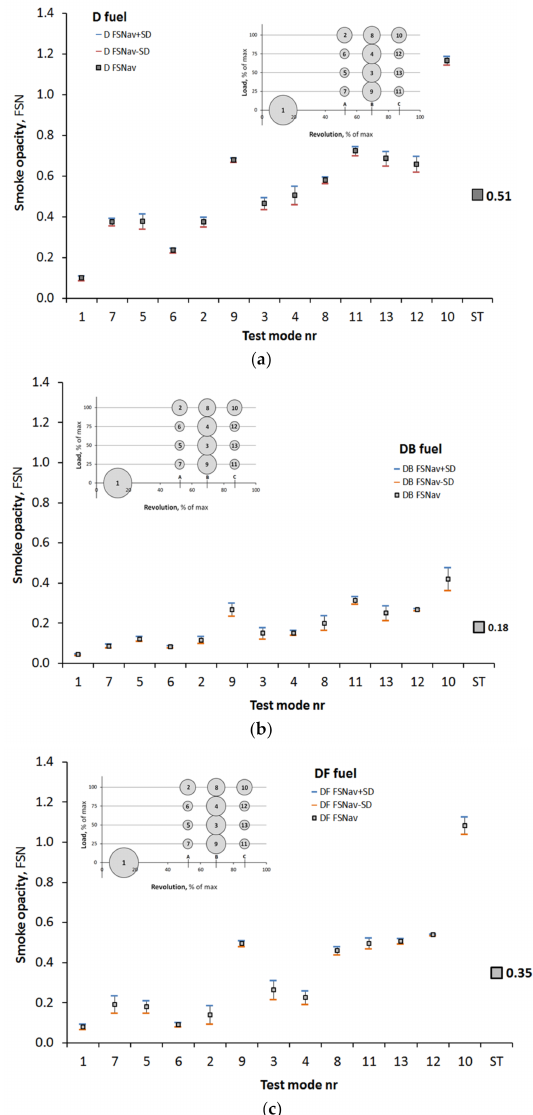
Figure 6. Emissions of smoke FSN of engine in ESC 13 mode test fed with D ( a ), DB fuel ( b ), and DF fuel ( c ).